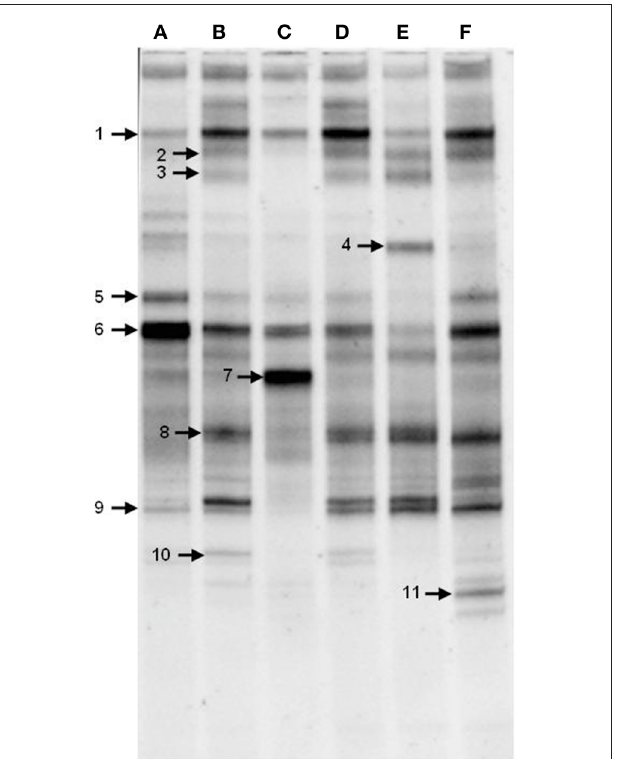
FIGURE 6 | DGGE profiles of 16S rRNA gene fragments amplified from total community DNA recovered from AK6 cultures grown on different sulfur sources. Glucose was provided as carbon source for all cultures and dibenzothiophene was also tested without glucose addition. lane A , benzothiophene; lane B 4,6-dimethyldibenzothiophene; lane C , dibenzothiophene (without glucose); lane D , dibenzothiophene; lane E , dibenzylsulfide; lane F , 4-methyldibenzothiophene. Faint DGGE bands representing PCR artifacts were neglected.